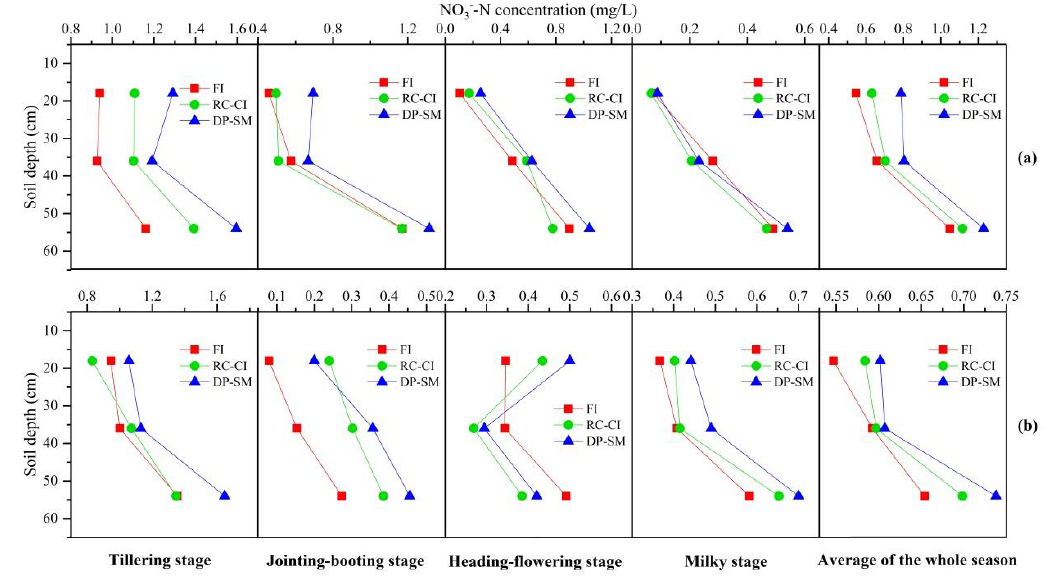
Figure 5. Vertical change of NO 3 − -N concentration in soil water at the depth of 18, 36 and 54 cm in ( a ) 2017 and ( b ) 2018.